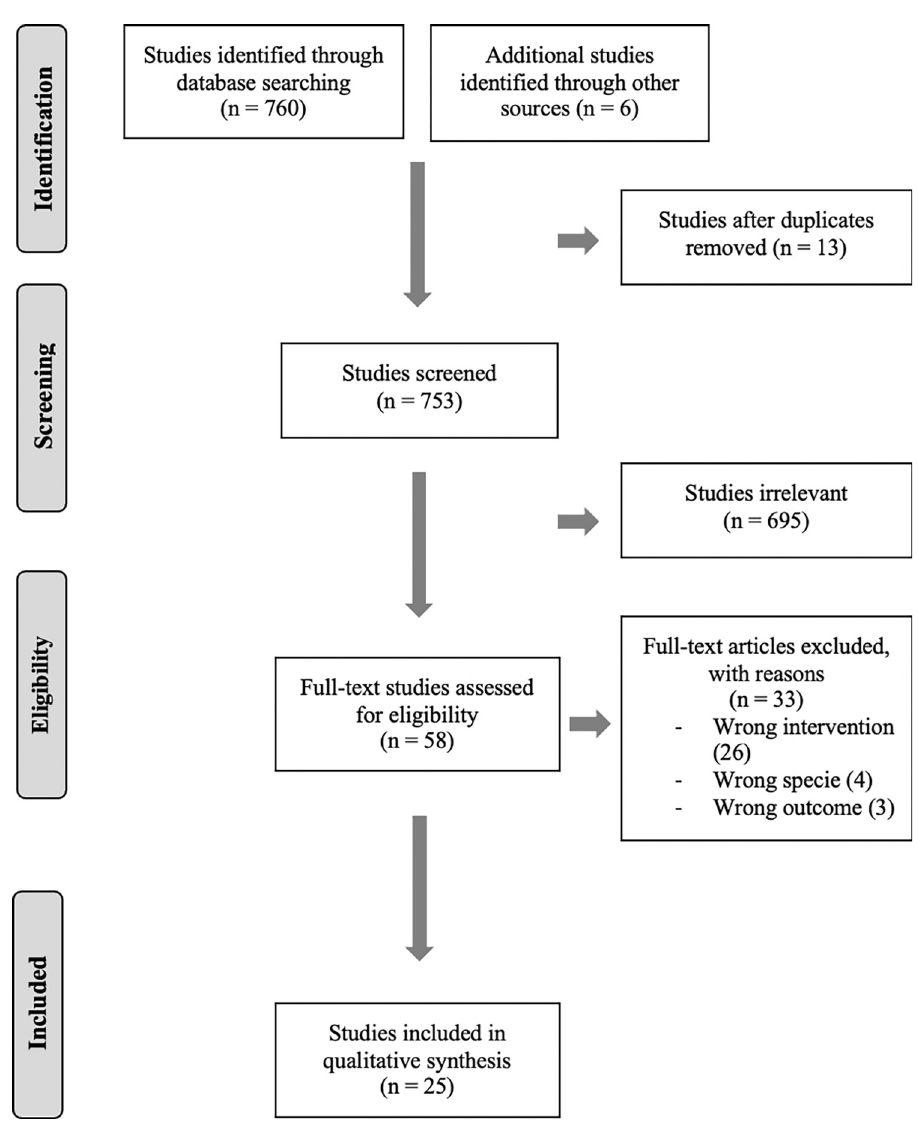
Fig 1. PRISMA flow diagram. Study screening flow chart for studies identified in the systematic literature review